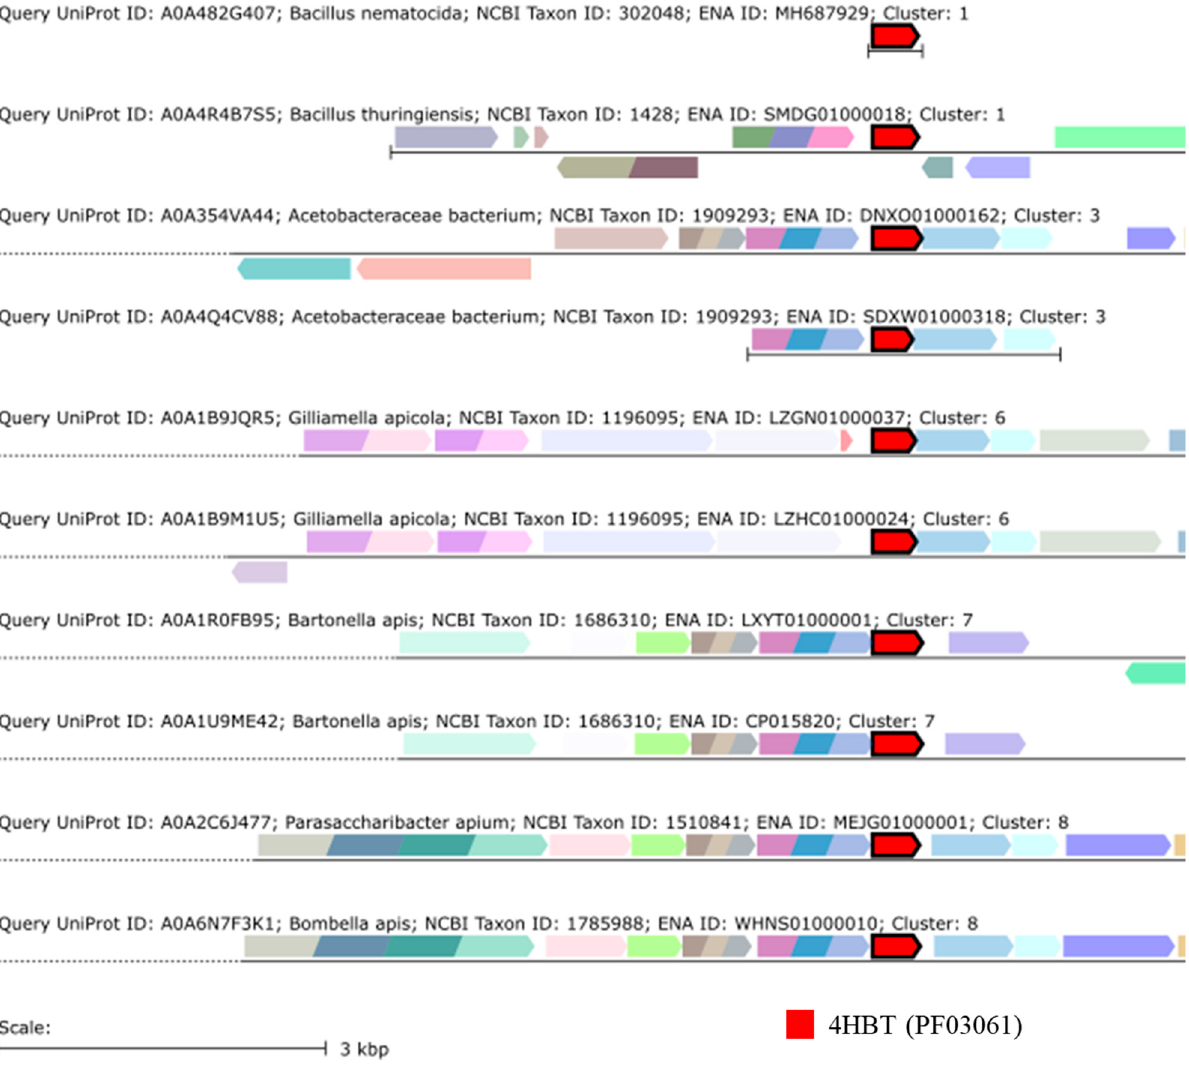
Figure 5. Genome Neighborhood Diagrams (GNDs) showing the 4HBT Thioesterase superfamily (PF03061) (red) in the genomes of the representative bacterial species from clusters 1, 3, 6, 7 and 8.